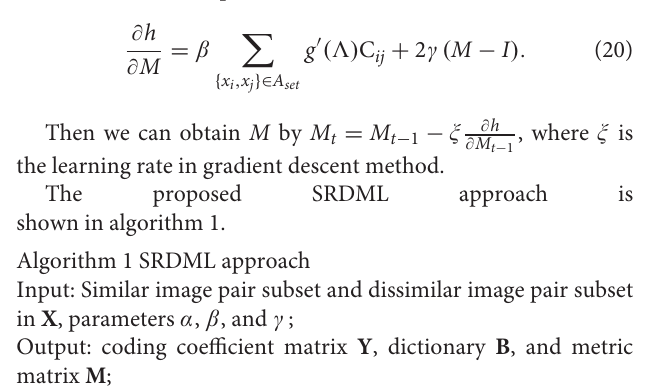
Algorithm 1 SRDML approach